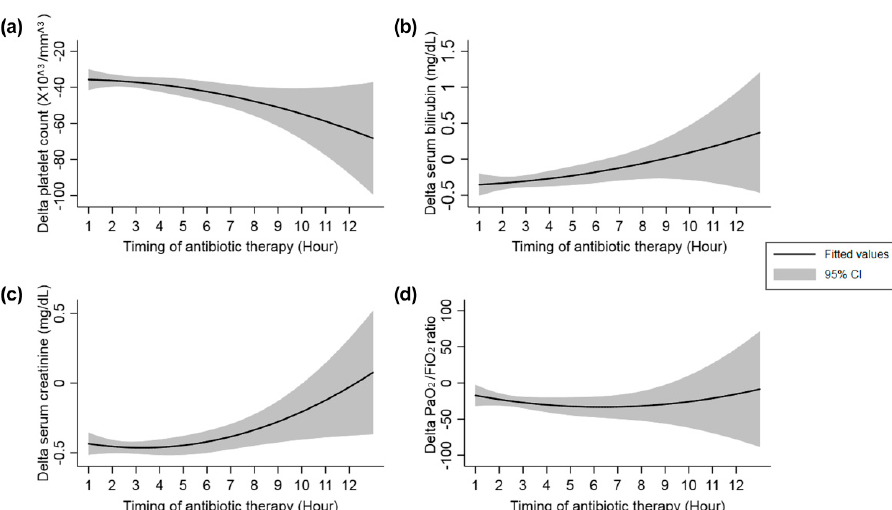
Figure 3. Changes in the measured parameters according to the timing of first antibiotic therapy. ( a ) δ -Platelet count, ( b ) δ -serum bilirubin level, ( c ) δ -serum creatinine level, and ( d ) δ - PaO 2 /FiO 2 ratio.